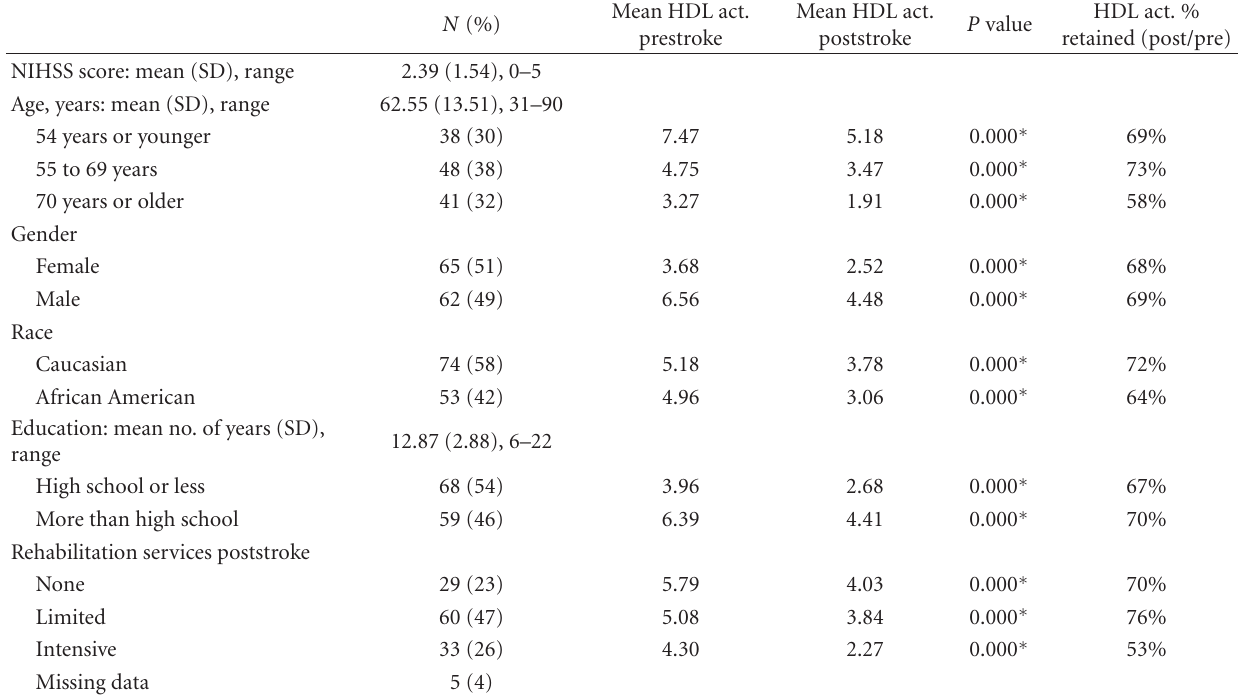
Table 1: Demographics, mean pre- and post-HDL activities, and mean % HDL activities retained, N = 127.